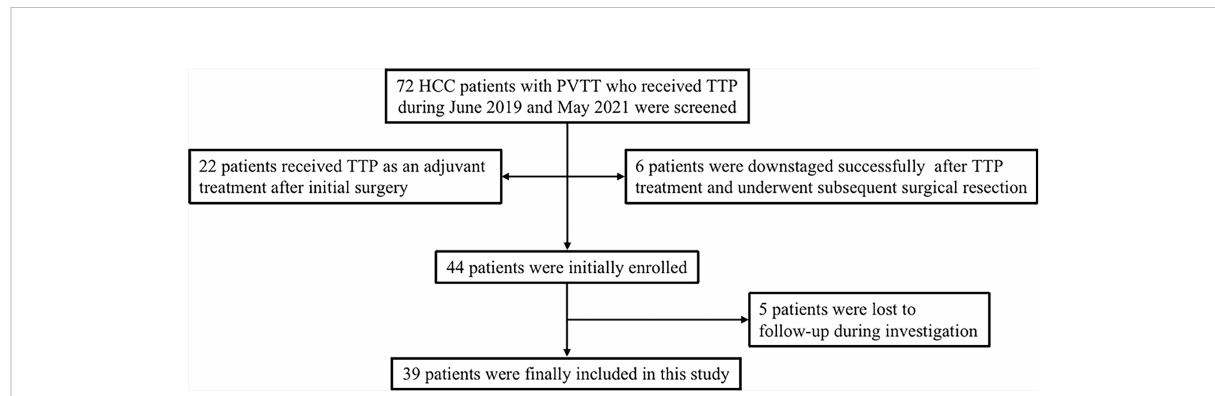
FIGURE 1 Flow diagram of patient enrollment. HCC, hepatocellular carcinoma; PVTT, portal vein tumor thrombus; TTP, TACE plus antiangiogenic-targeted treatment and anti-PD-1